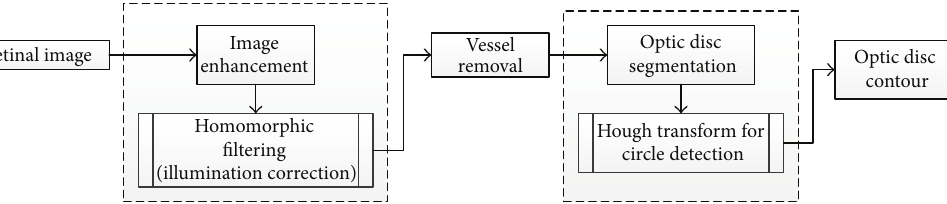
Figure 11: Flowchart for algorithm proposed in [33].